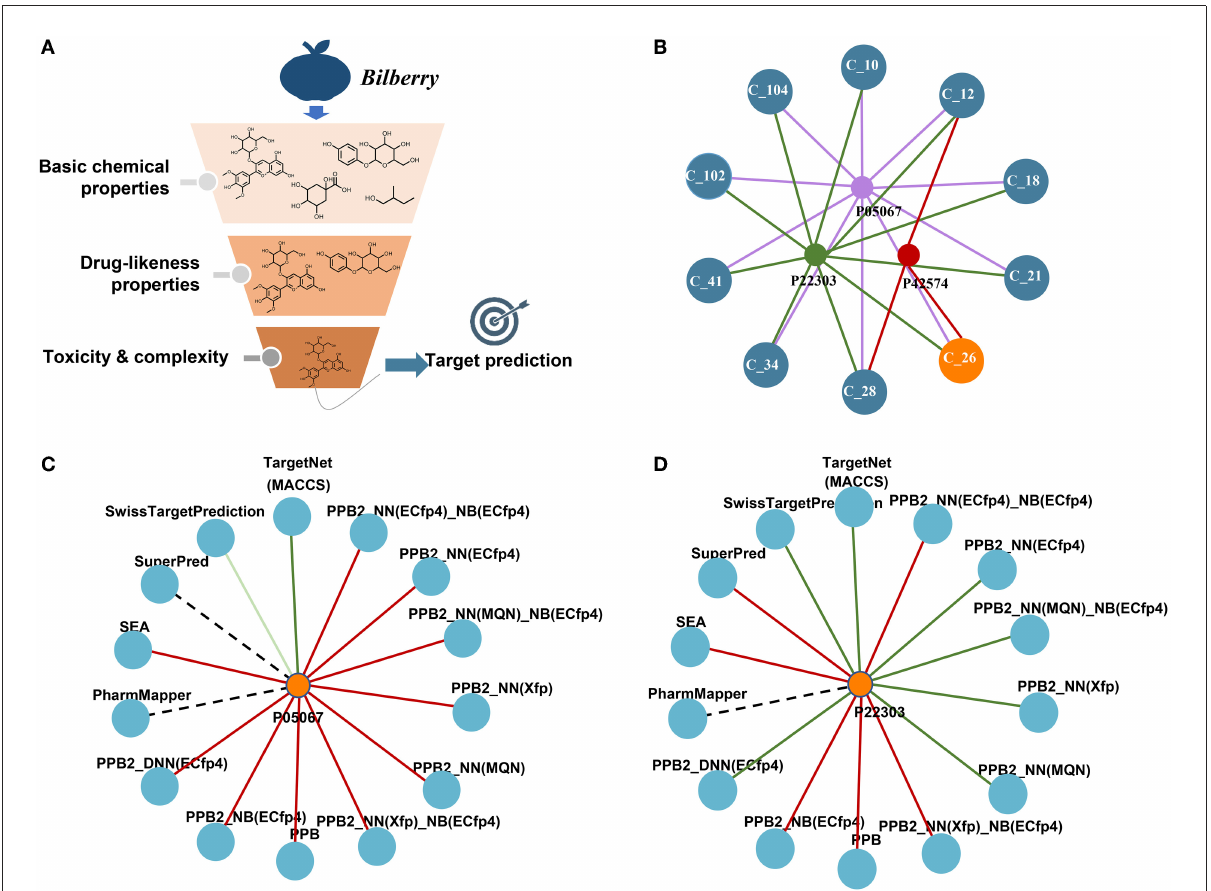
FIGURE1 Screening of neuroprotective ingredients by cheminformatics approaches. (A) The schema of the pipeline. (B) The predicted targets and their interactions with the top 10 compounds. C_26 represents Ma-3-gal-Cl. (C) The predicted interactions between Ma-3-gal-Cl and A β (1–42) by different tools. The red line represents no hit, the dark green represents a hit, and the light green line represents a hit out of the top 20. The dotted line means the tool does not cover this target. (D) The predicted interactions between Ma-3-gal-Cl and AChE by different